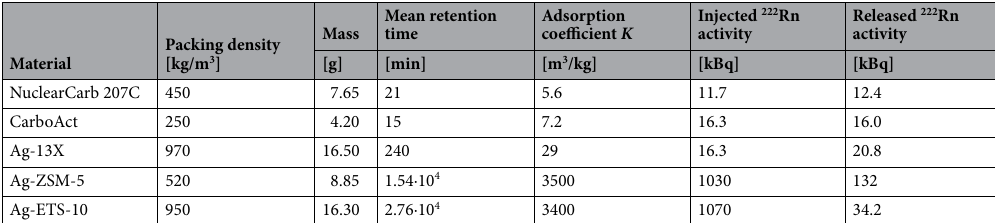
Table 1. Overview of experimental parameters, obtained retention times and adsorption coefficients for the five tested materials given in Fig. 1; for NuclearCarb 207C, CarboAct and Ag-13X the injected and released 222 Rn activities do not significantly differ within their uncertainties (± 10% at a confidence level of 68%).